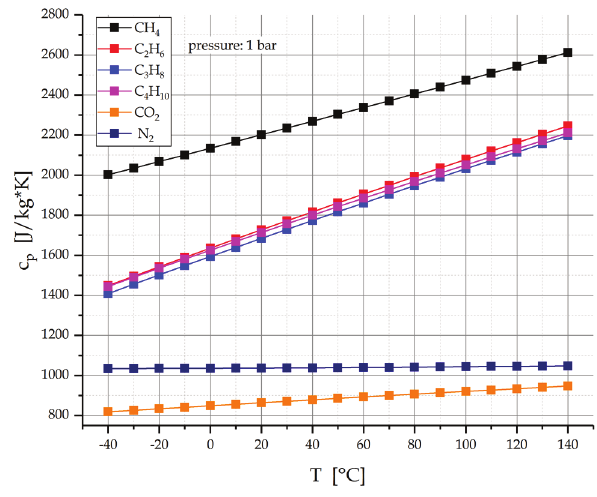
Fig. 2. Heat capacity at constant pressure for different gases and tempera-